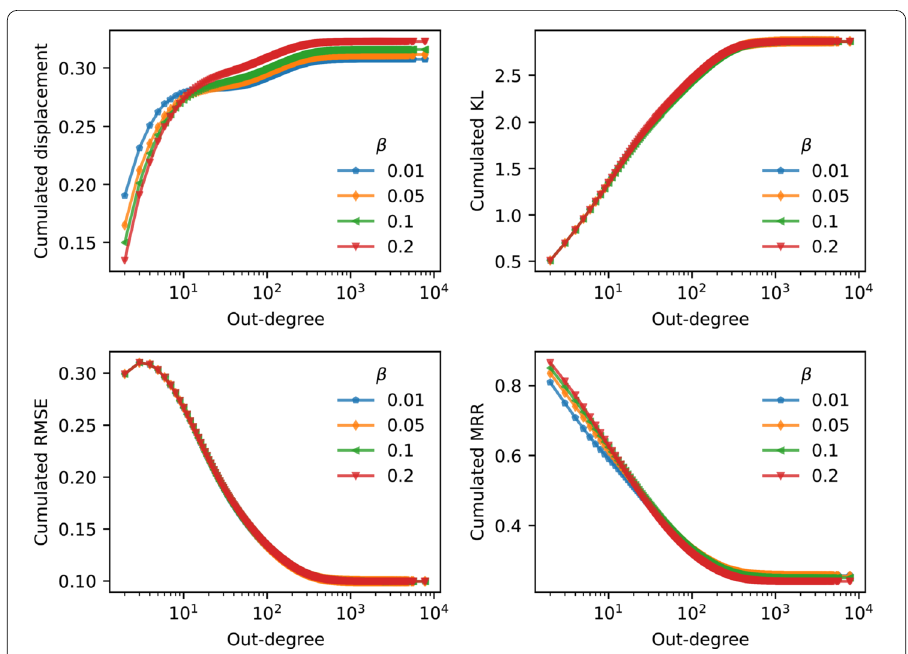
Figure 7 Cumulated evaluation metrics on the Wikipedia network for varying damping factor β . Larger values of β tend to slightly favor low degree nodes for the displacement and MRR metrics